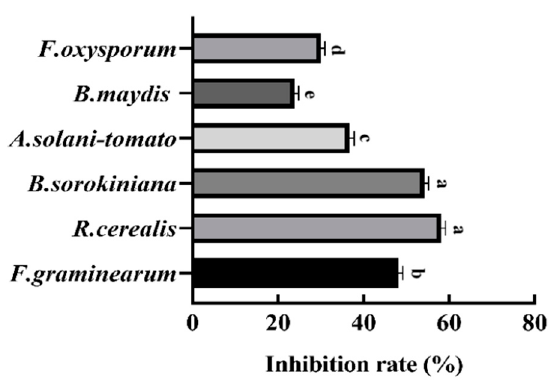
Figure 3. Antifungal activity of the B1302 strain against six pathogens. Bars labelled with different letters are significantly different at p < 0.05 using a Duncan’s multiple range test.